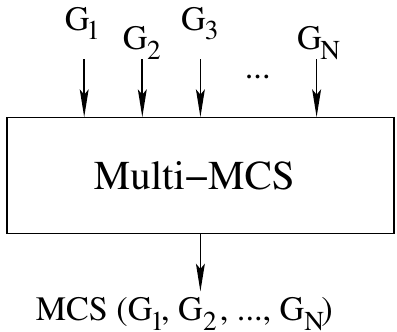
Figure 3. Computing the MCS of N graphs { G 1 , G 2 , . . . , G N } using a single branch-and-bound recursive function M ULTI -MCS ( G 1 , G 2 , . . . , G N